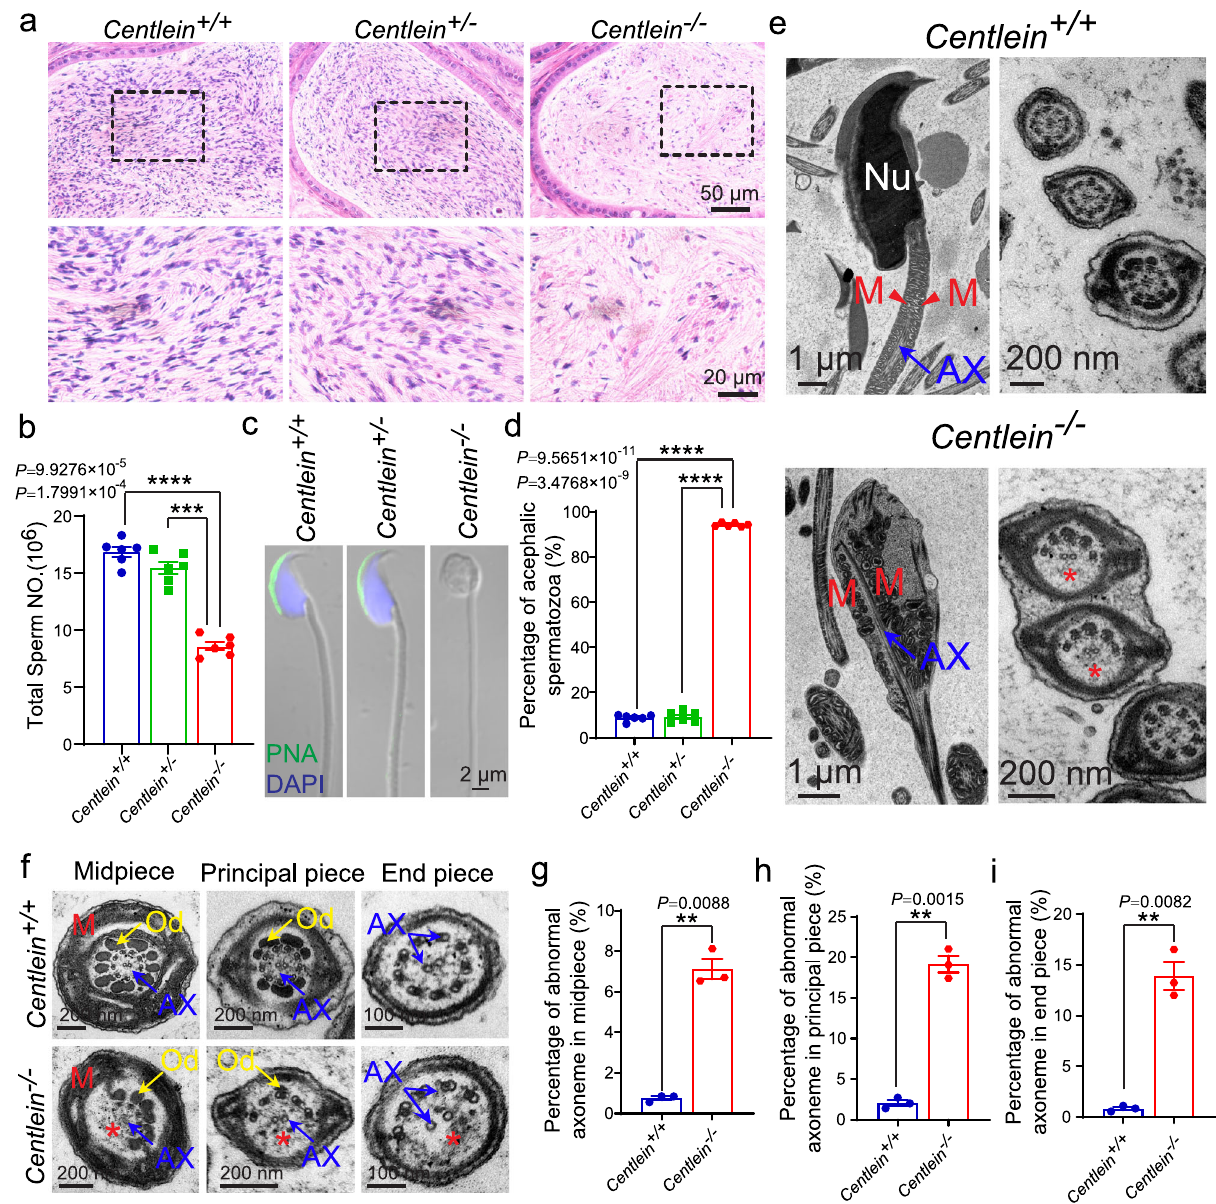
Fig. 3 Ablation of Centlein leads to acephalic spermatozoa. a Fewer sperm heads are present in Centlein − / − epididymis. The H&E staining of the caudal epididymis of Centlein + / + , Centlein + / − , and Centlein − / − mice are shown. The spermatozoa within the Centlein -de fi cient caudal epididymis appear to be stained less with hematoxylin compared with those in the Centlein + / + and Centlein + / − caudal epididymis. Biologically independent mice for each genotype were examined in three separate experiments with similar results. b The sperm counts in the caudal epididymis of Centlein − / − mice was signi fi cantly reduced compared with Centlein + / + and Centlein + / − mice ( n = 6 independent experiments). Data are presented as mean ± SEM. A two-tailed Student ’ s t test was performed, *** P < 0.001, **** P 0.0001. c The Centlein -null spermatozoa are headless. Single-sperm PNA (green) staining was performed using Centlein + / + , Centlein + / − , and Centlein − / − spermatozoa. Nuclei were stained with DAPI (blue). d Proportion of decapitated tails in Centlein + / + , Centlein + / − , and Centlein − / − caudal epididymis ( n = 6 independent experiments). Data are presented as mean ± SEM. A two-tailed Student ’ s t test was performed, **** P < 0.0001. e Ultrastructure of Centlein + / + and Centlein − / − spermatozoa from caudal epididymis showing that the Centlein -null spermatozoa had no sperm head and contained a residual droplet of cytoplasm at the top of the fl agellum with misarranged mitochondria inside. Nu: nuclear, M (red): mitochondrion, AX (blue): axoneme. The red asterisk indicates the missing microtubule doublets of axoneme in Centlein- null spermatozoa. Biologically independent mice were examined in three separate experiments with similar results. f Ultrastructure of the midpiece, principal piece, and end piece of Centlein + / + and Centlein − / − spermatozoa from caudal epididymis. M (red): mitochondrion, AX (blue): axoneme, Od (yellow): outer dense fi bers. The red asterisk indicates the missing microtubule doublets of axoneme in Centlein- null spermatozoa. g – i Quanti fi cation ratio of abnormal axoneme in midpiece ( g ), principal piece ( h ), and the end piece ( i ) of Centlein + / + and Centlein − / − spermatozoa ( n = 3 independent experiments). Data are presented as mean ± SEM. A two-tailed Student ’ s t test was performed, ** P < 0.01. Source data are provided as a Source Data fi le. Blue dots indicate Centlein + / + mice, green dots indicate Centlein + / − mice, and red dots indicate Centlein − / −